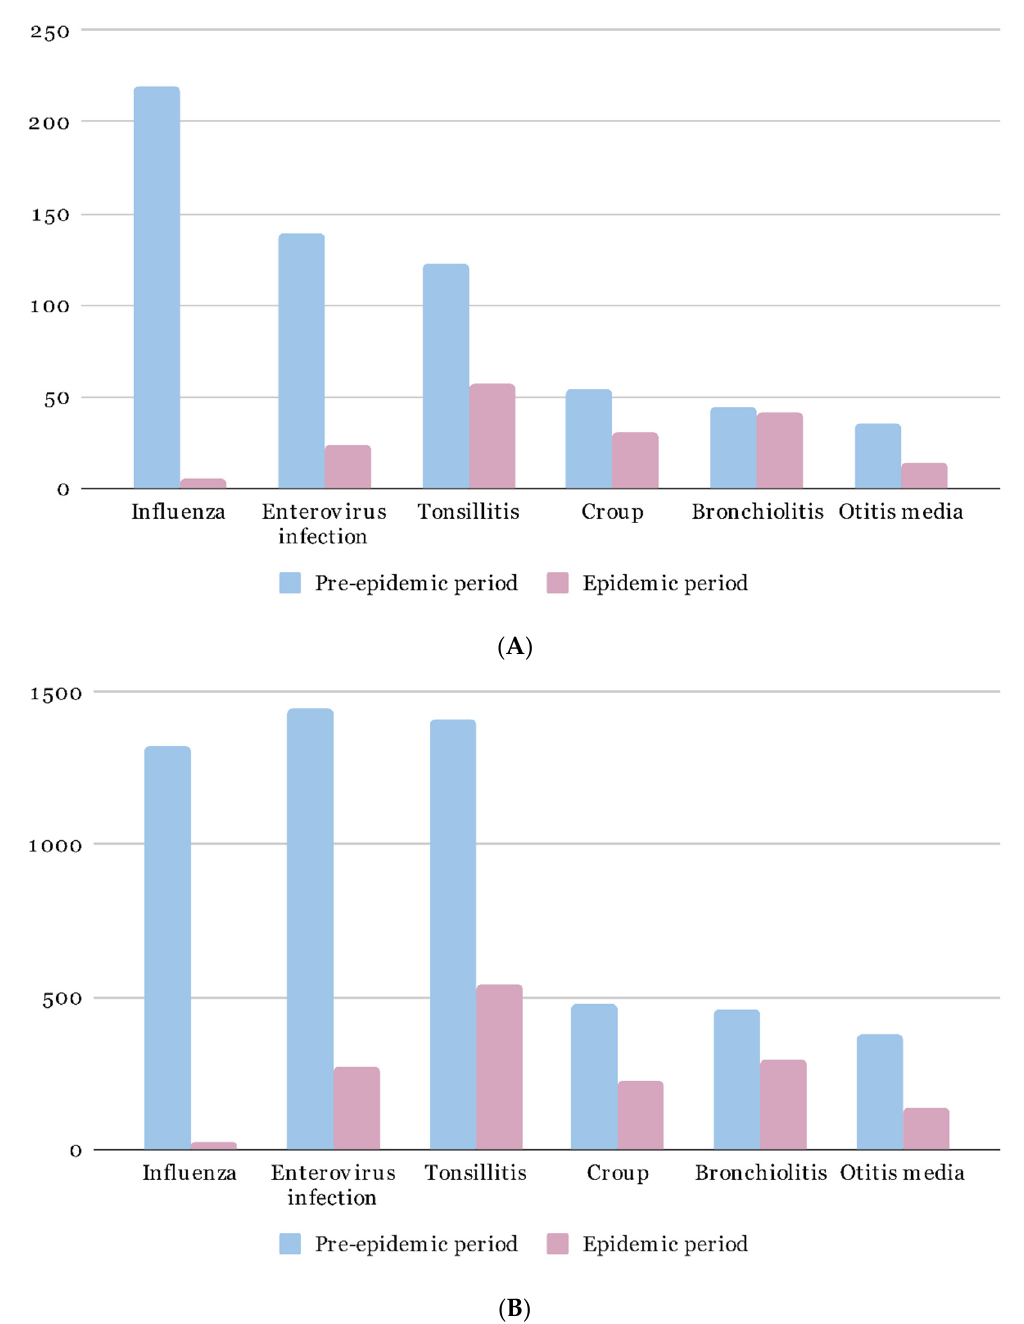
Figure 2. Number of patients with common pediatric infectious diseases in the pre-epidemic and epidemic periods. ( A ): Number of patients diagnosed by EM residents; ( B ): Total patient number. Table 3. Top 10 diagnoses seen by EM residents in the pre-epidemic and epidemic periods. The age group distribution was calculated and compared (Figure 3). The proportion of neonates/infants and toddlers was elevated in the epidemic period. In contrast,